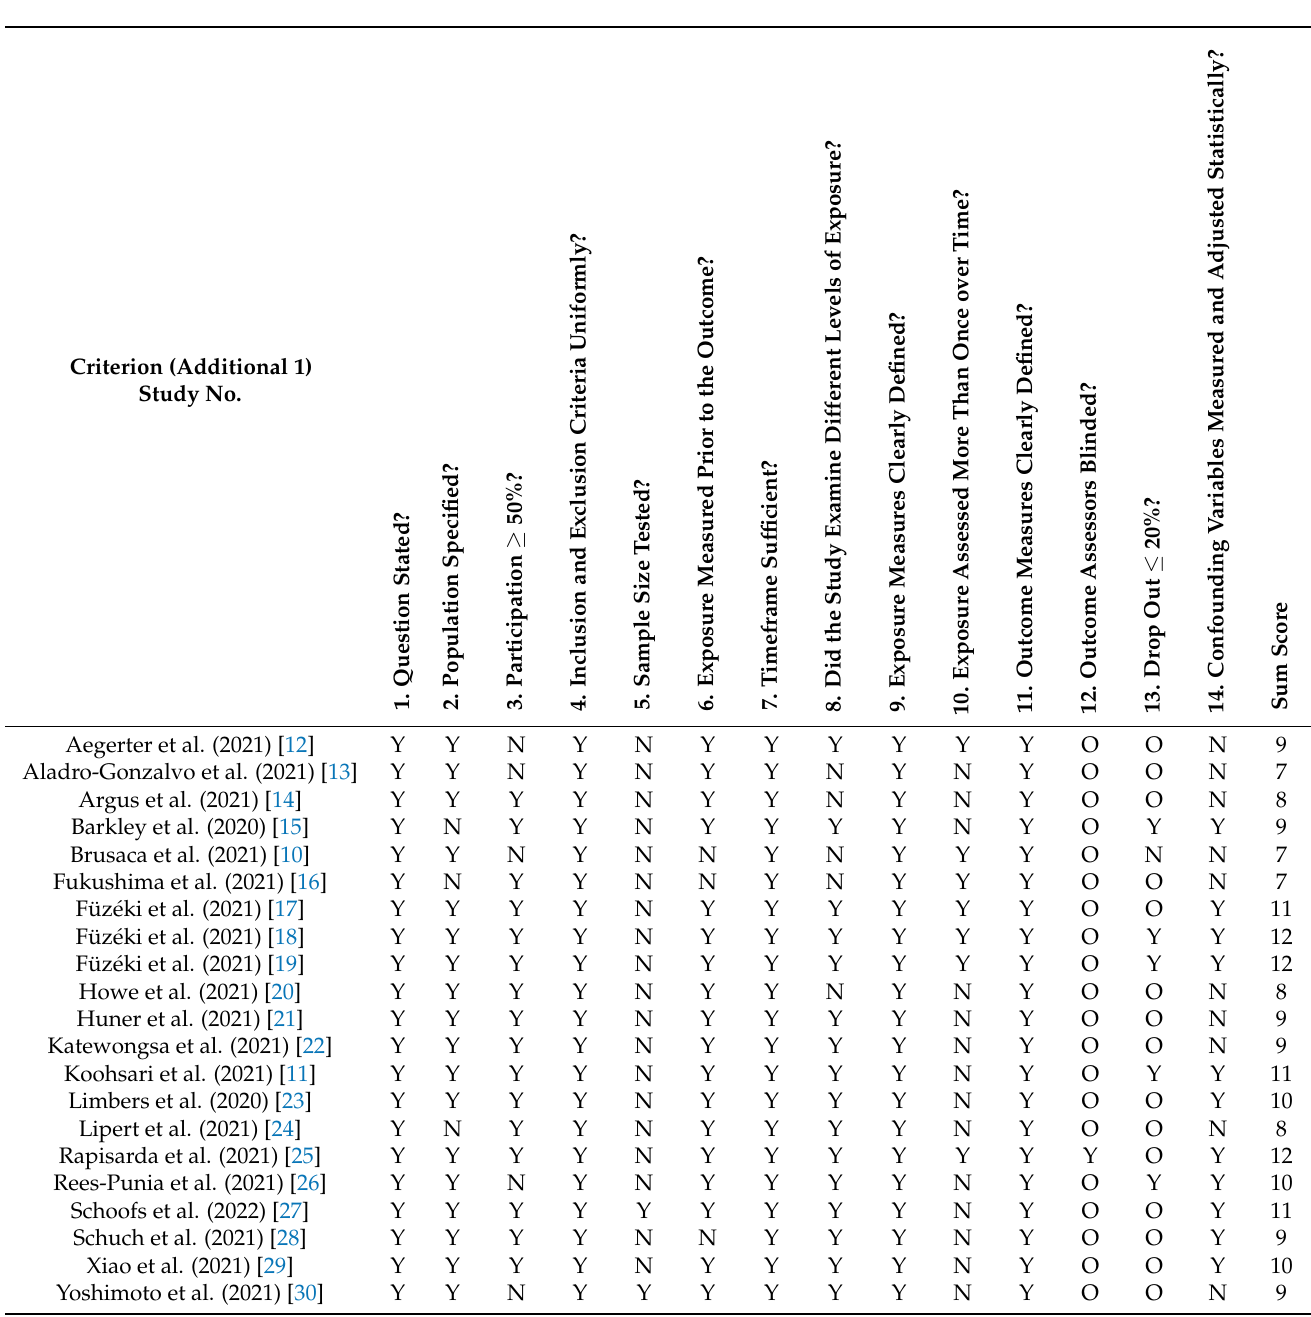
Table 2. Risk of